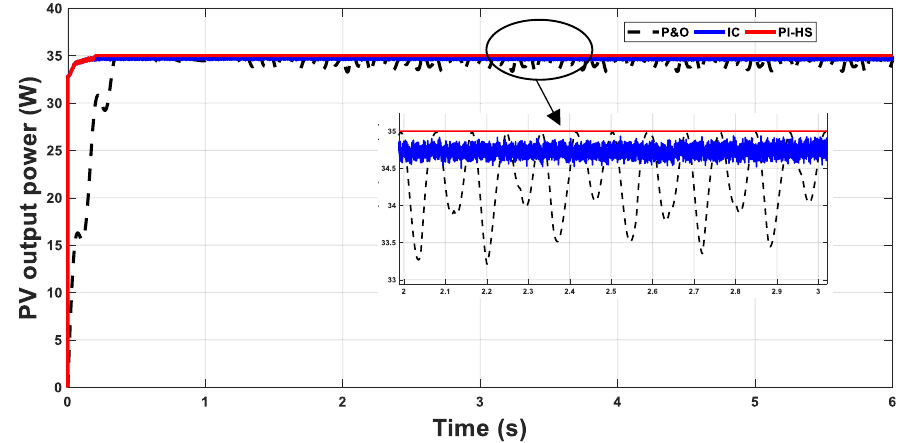
Figure 5. MPP at 25 °C and 1000 W/m 2 .